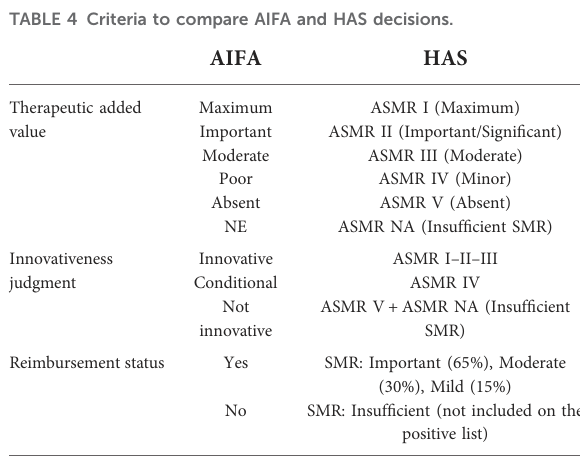
TABLE 4 Criteria to compare AIFA and HAS